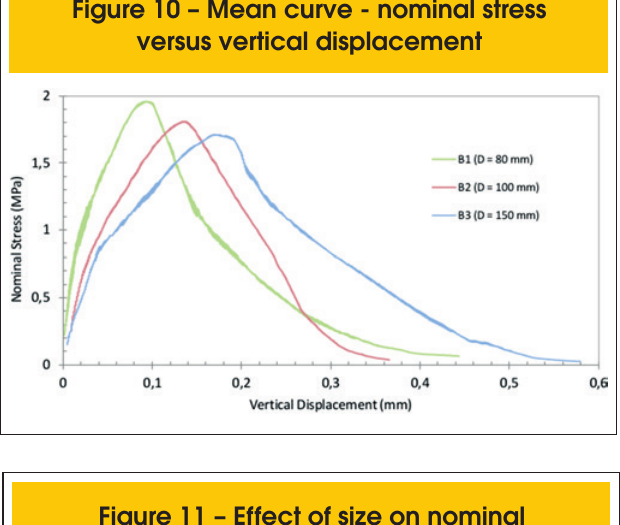
Figure 11 – Effect of size on nominal stress and vertical displacement associated with peak